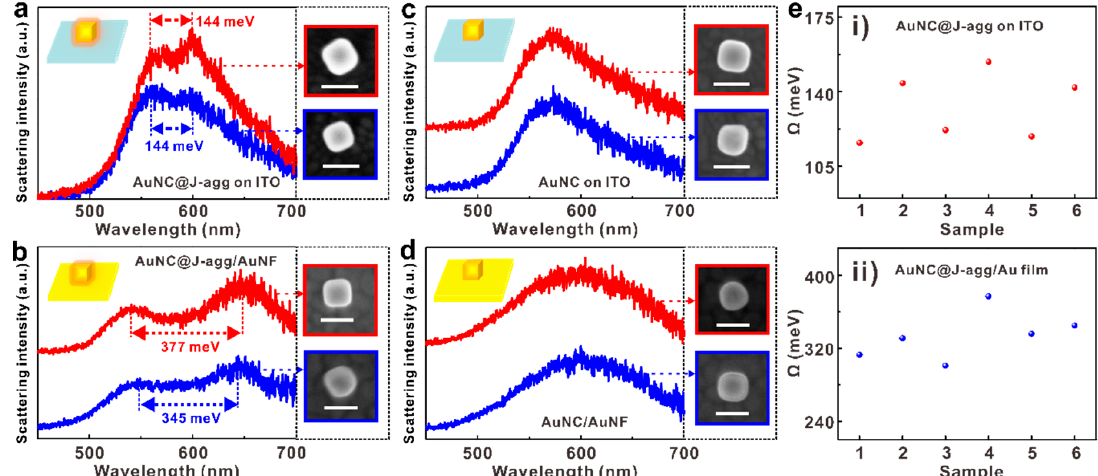
Figure 4. Characterization of complex strong coupling systems. ( a ) Scattering spectra of two AuNC@J-agg hybrid samples on the ITO substrate, with Rabi splitting of 144 meV. ( b ) Scattering spectra of two AuNC@J-agg/AuNF samples, with Rabi splitting of 327 meV and 341 meV. ( c ) Scattering spectra of two AuNC samples on the ITO substrate. ( d ) Scattering spectra of two AuNC on AuNF samples. ( e ) The comparison of Rabi splitting energy of AuNC@J-agg on the ITO and AuNC@J-agg/AuNF systems, which are statistically collected from 12 samples.